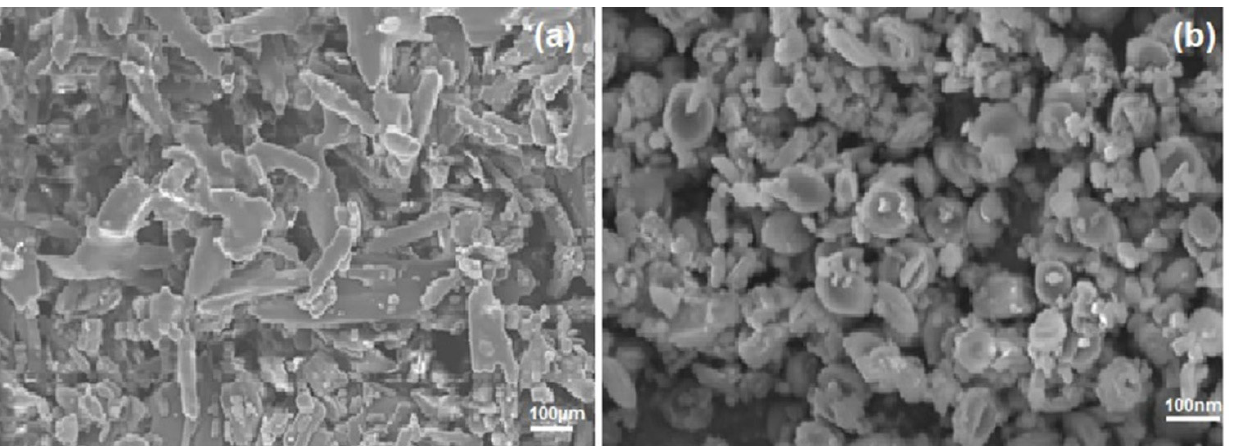
Figure 6. ( a ) FT-IR spectra and ( b ) XRD pattern of CRL-MC and -NCs . 3.9. XRD When the formulation was formed as nanoparticles, the XRD was utilised to analyse the molecular structure and crystalline nature of the drug. The amount of this feature was determined by the CRL chemical composition and physical hardness, as well as powder density. The characteristic diffraction peaks were obtained for CRL-MC and -NCs. As shown in Figure 6b, of CRL-MC’s intensity from 0 to 40°, distinctive peaks at 14.9, 17.2, 18.2, 23.6, and 26°, are comparable with the XRD pattern of crystalline CRL reported in the previous study [29]. The prepared CRL-NC diffractogram peaks around 2 θ were at a range of 14.90, 17.12, 17.26, 21.98, and 26.36°, which are super imposable and reveal the characteristic peak of CRL, thus indicating the absence of chemical instability in the solid